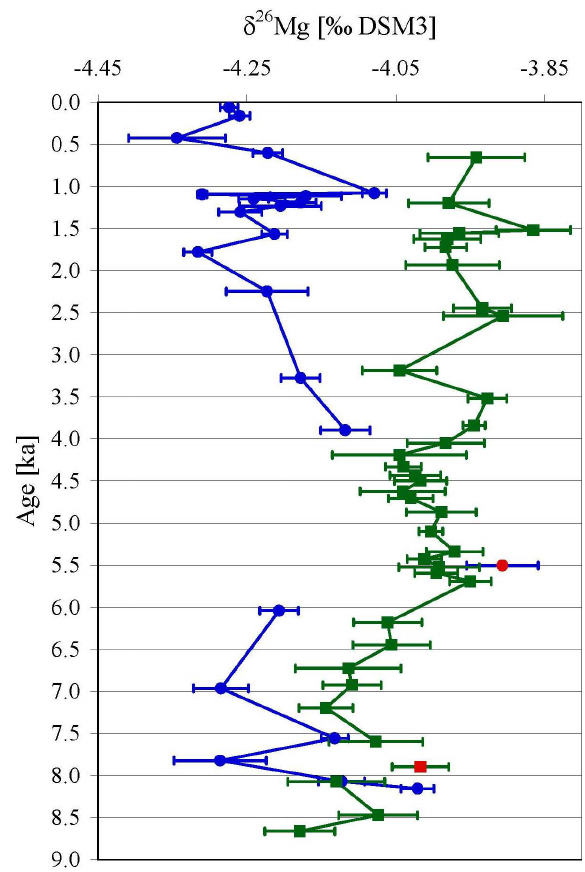
Fig. 11. Magnesium isotope records of the stalagmites AH-1 (green squares) and BU 4 (blue circles) from Germany plotted against age in ka BP. Samples taken from detrital layers are marked with red squares or